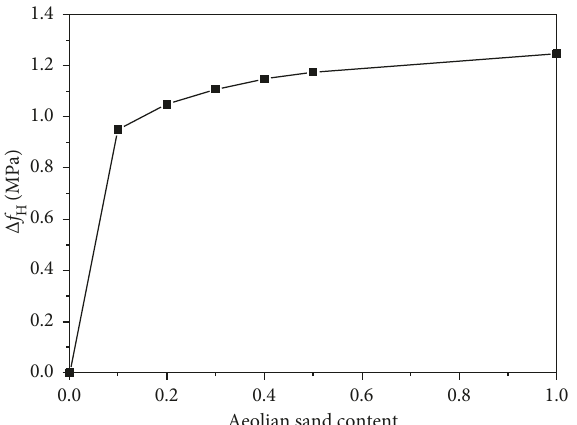
Figure 16: Relation between Δ f